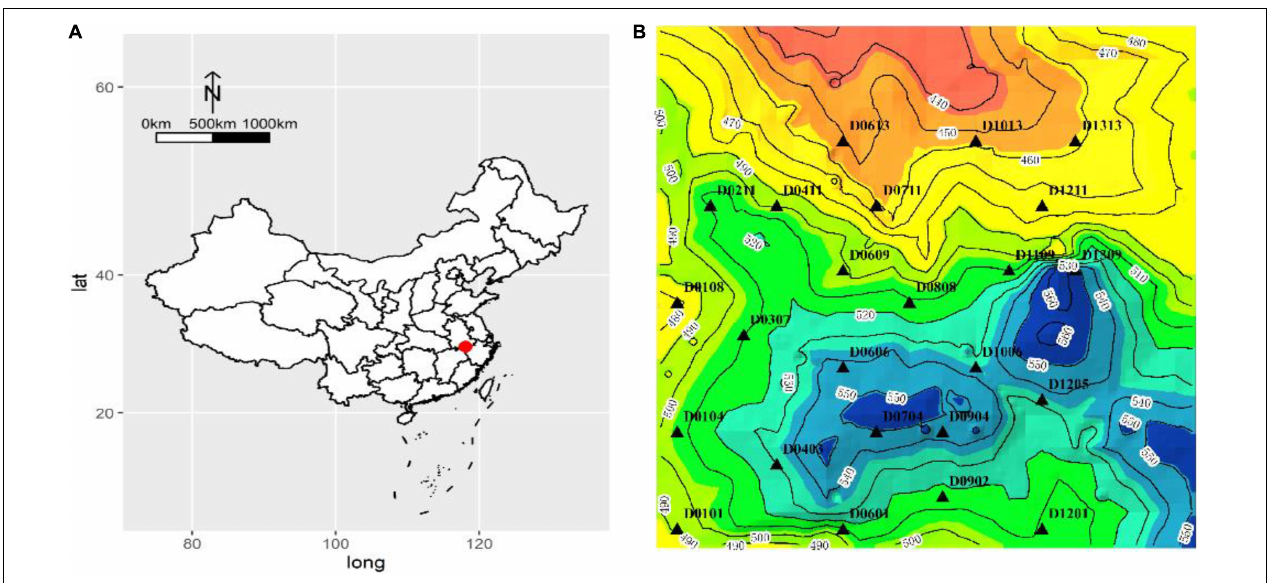
FIGURE 1 | (A) Geographic location of the Forest Dynamics Plot at Huangshan (HS) and (B) the sampling points